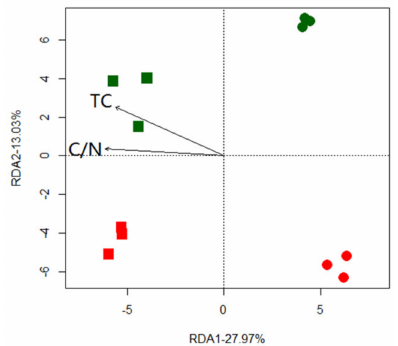
Figure 2. Redundancy analysis (RDA) of the ureolytic microflora and environmental